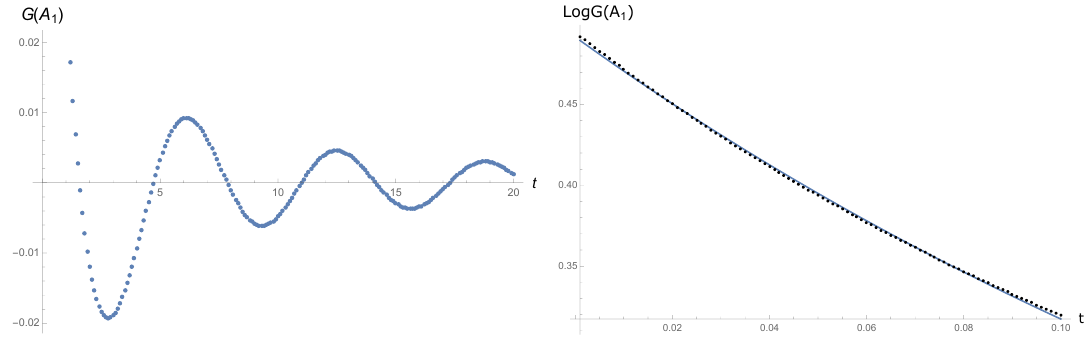
Figure 3 . A plot of the two point function in the A 1 phase ( (cid:22) = 1 ; (cid:12) = 0 : 1 ; L = 1). Left: the late time behaviour is oscillating with a power law decaying envelope. Right: the early time behaviour is very well approximated by a decaying exponential function G ( t ) (cid:24) exp( (cid:0) 4 : 38 t ) drawn with a continuous curve (logarithmic